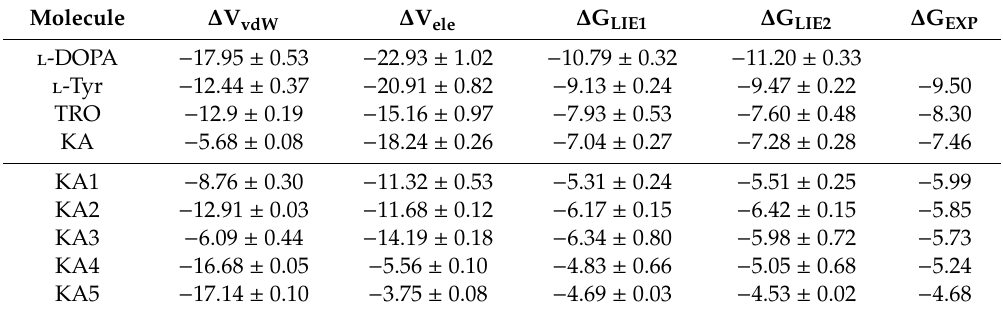
Table 4. Theoretical and experimental binding free energy values (in kcal / mol) calculated for each tyrosinase (TYR) system.